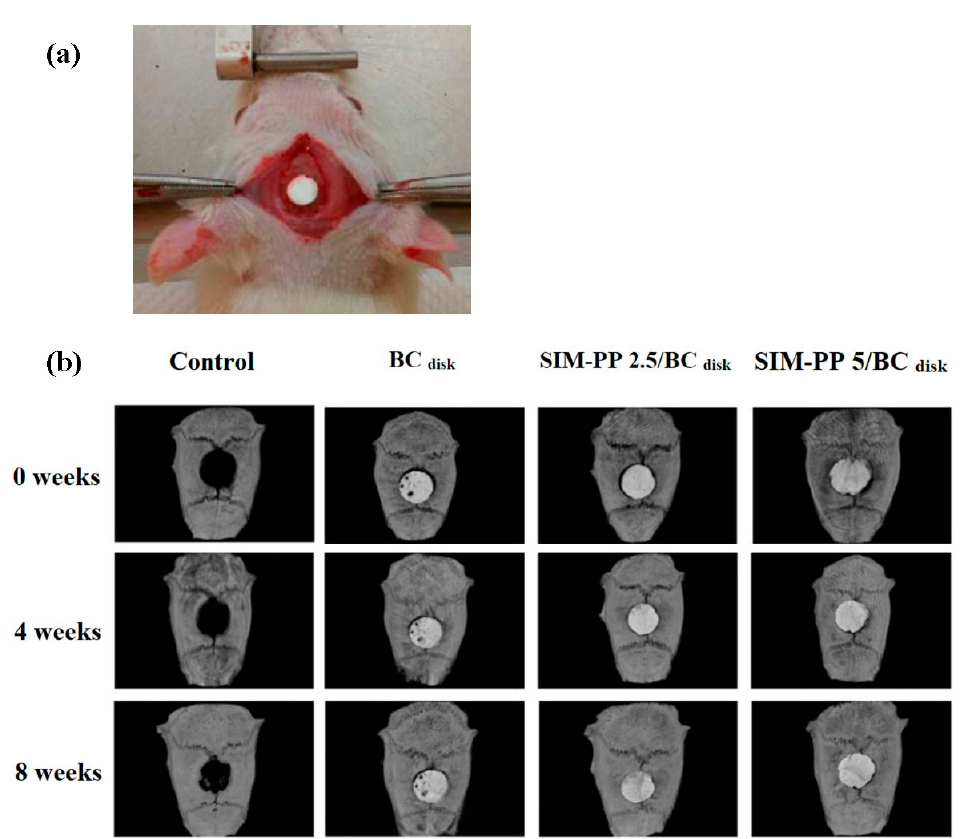
Figure 3. Representative calvarial bone defects of the rat model are shown in experimental photograph ( a ). The radiography study observed ( b ) calvarial bone defects of the rat model at 0, 4 and 8 weeks after implantation of 2.5 µ mol of SIM and 5.0 µ mol of SIM in SIM-PP/BC disk samples ( φ 5 mm; h 0.7 mm). Notes: calvarial bone defects only were used as controls.